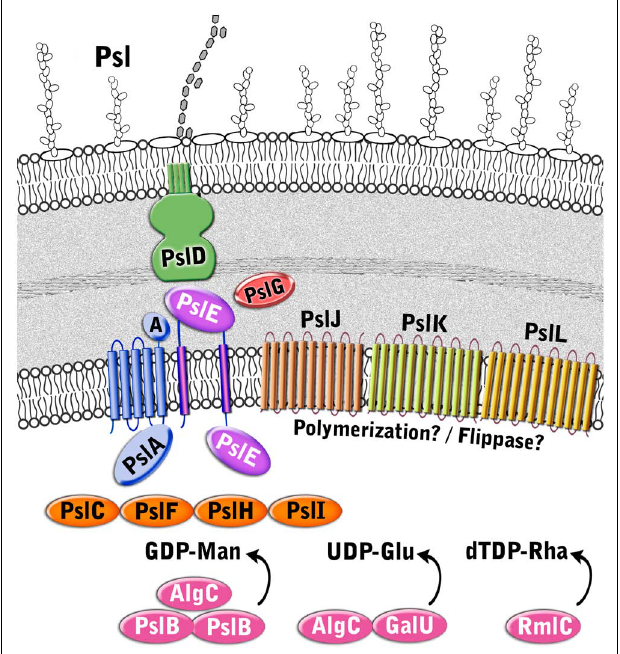
FIGURE 6 | Proposed structure of the Psl biosynthetic complex. The enzymes are color coded according to proposed function as described in Figure 3 .